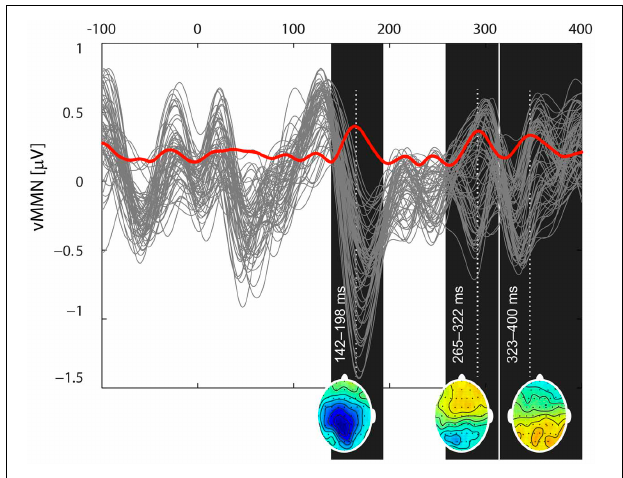
FIGURE 3 | Butterfly plot of the grand mean deviant-standard difference waveform at all channels including the vMMN (gray traces) and its global mean power (red trace) demonstrate the temporal dynamics of the vMMN. Three local extremes around which the intervals of interest were selected (142–198, 265–332, and 324–400) are marked as black rectangles. For the time points indicated by a white dotted line, potential distributions are plotted at the bottom of the appropriate